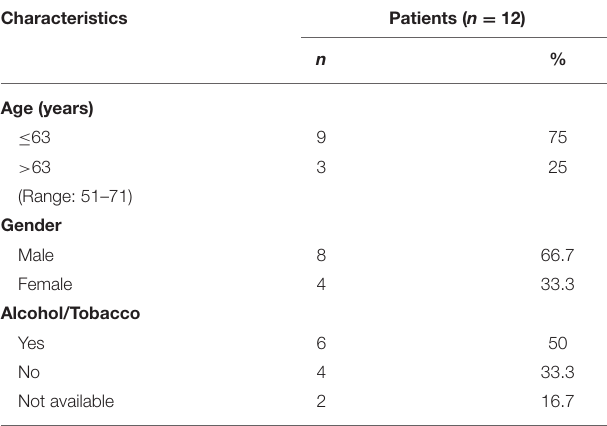
TABLE 2 | Clinicopathological data of healthy donors enrolled in this